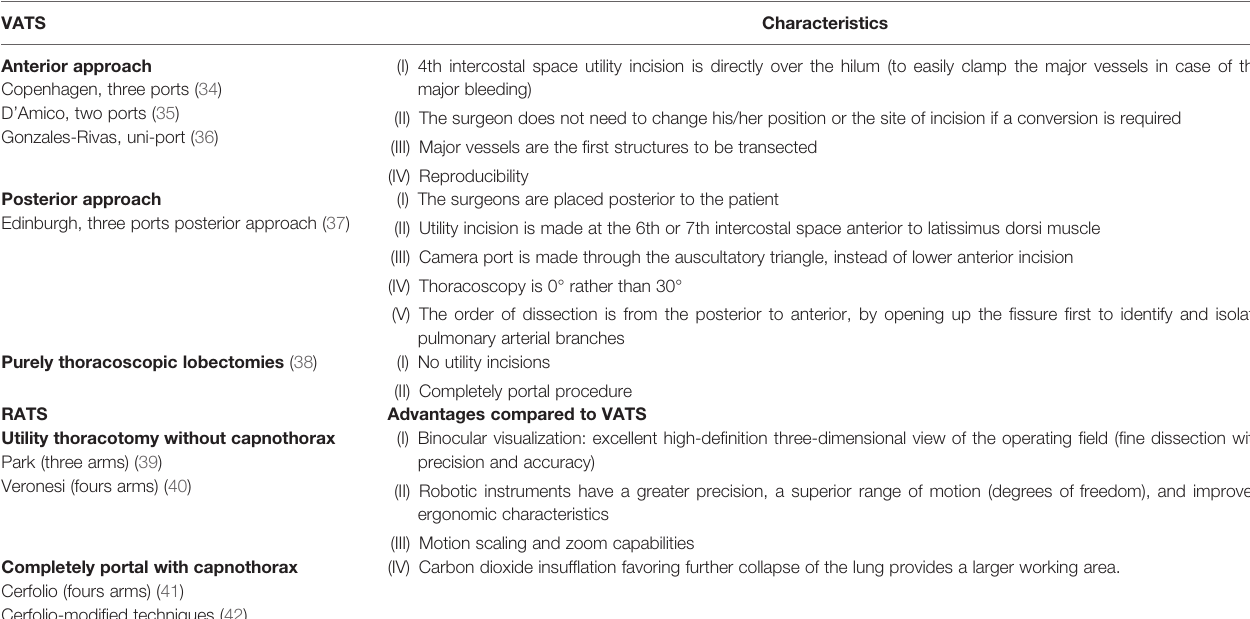
TABLE 2 | Minimally invasive surgical techniques to perform